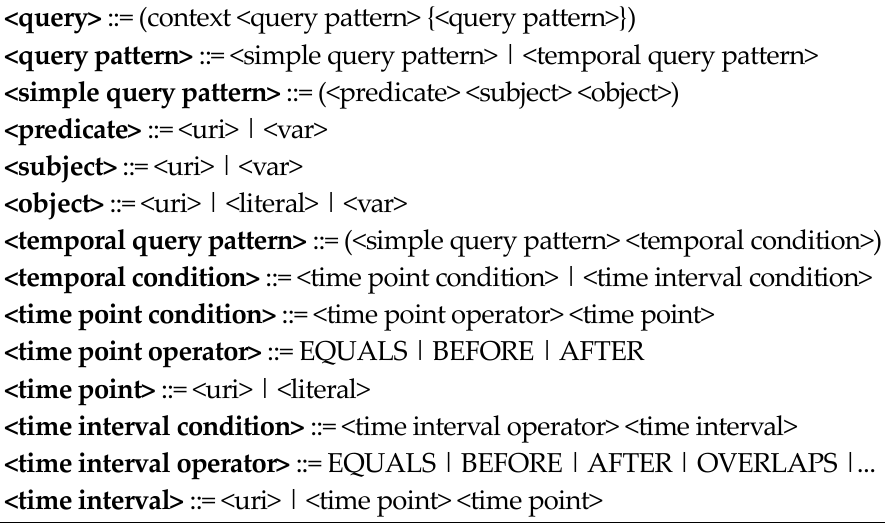
Figure 7. Grammar structure of the context query language.